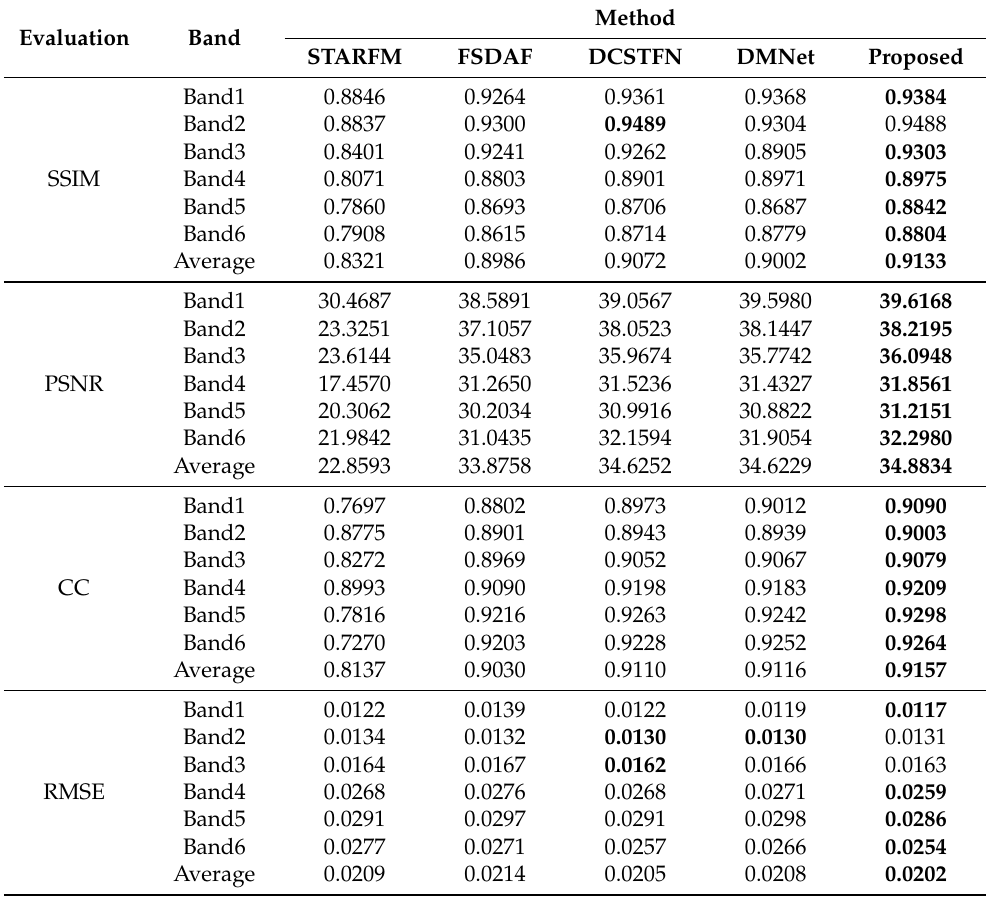
Table 2. Quantitative assessment of different STF methods on the LGC [46] dataset.